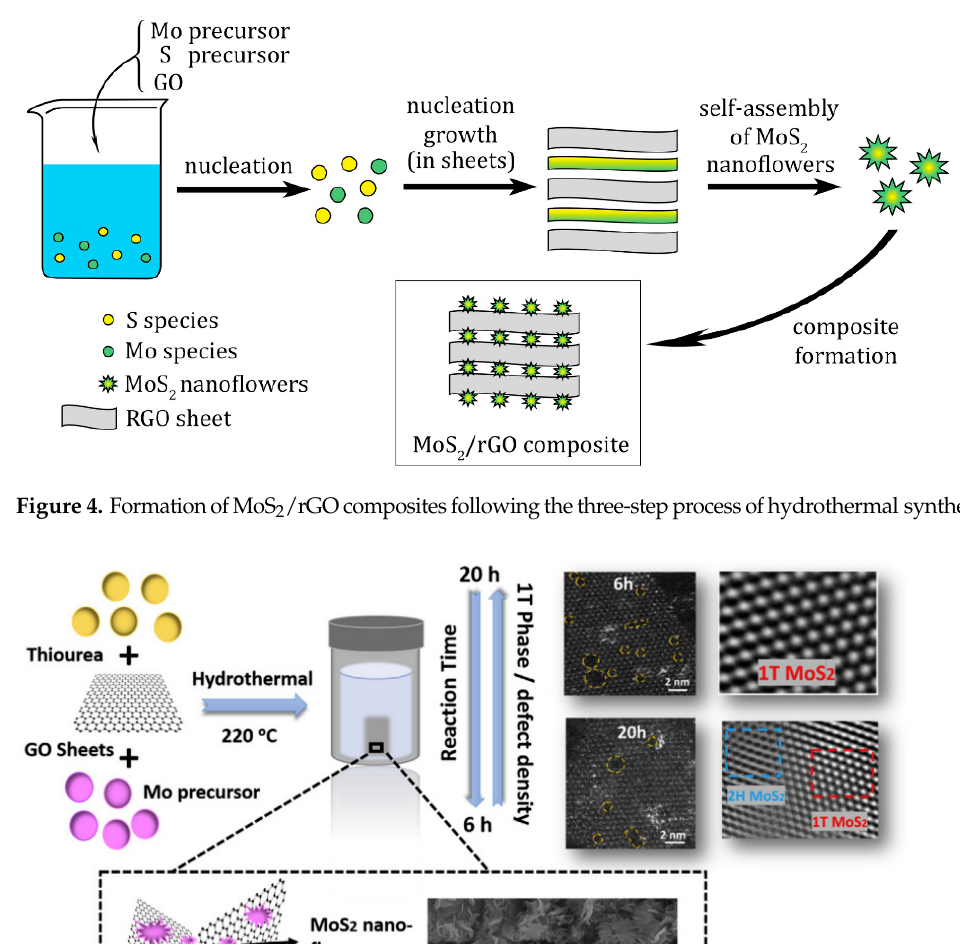
Figure 4. Formation of MoS 2 /rGO composites following the three-step process of hydrothermal syn- thesis.